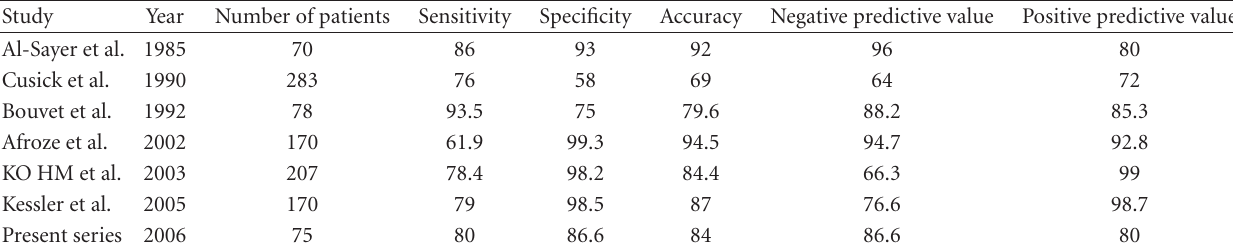
Table 7: Comparison of results of present study with previous